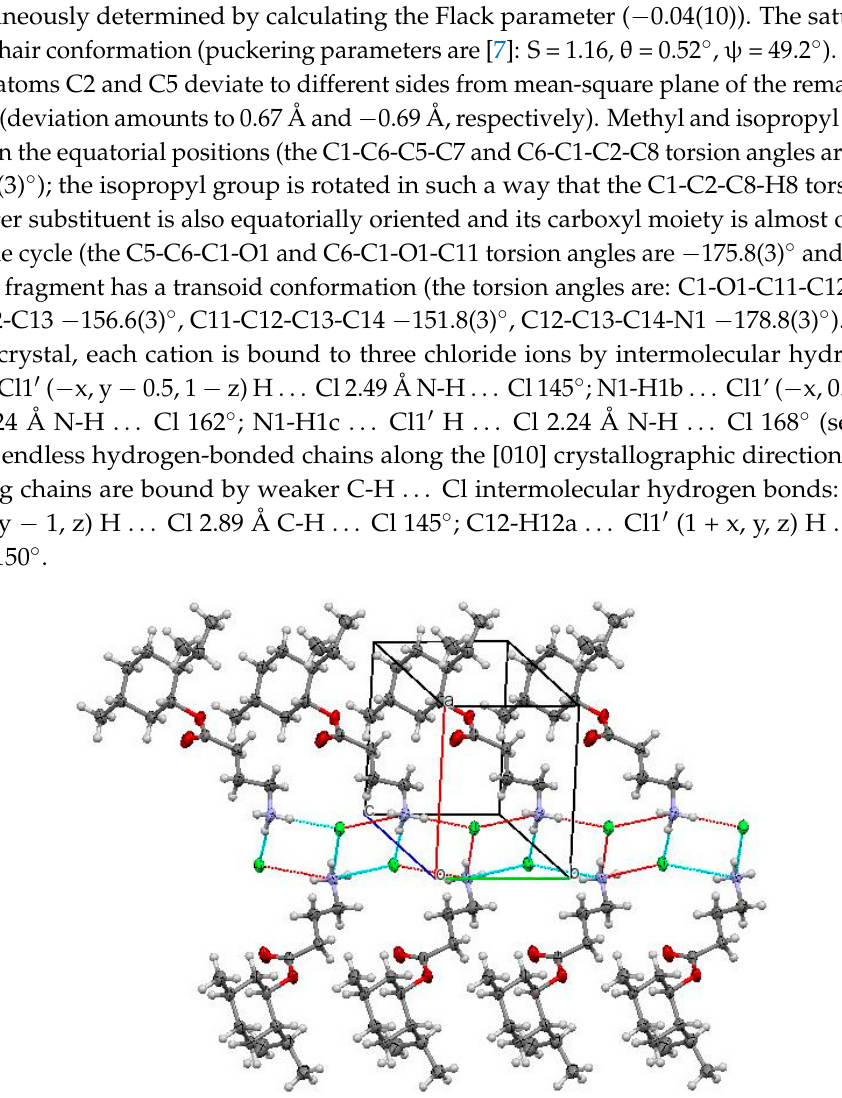
Figure 2. Infinite chain formed by (1 R ,2 S ,5 R )-2-isopropyl-5-methylcyclohexyl 4-aminobutyrate hydrochloride along the [010] crystallographic direction in the crystal phase.